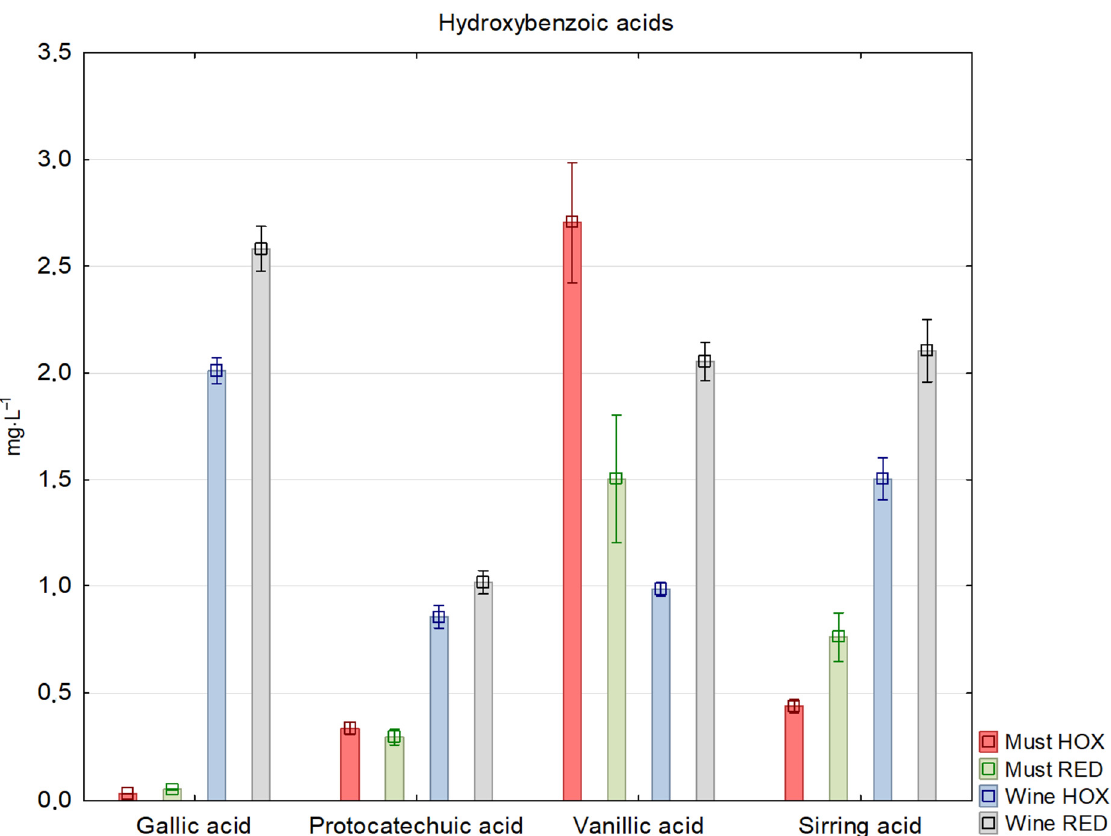
Figure 2. Concentration of selected hydroxybenzoic acids and esters in reductive (RED) and hyperoxidized (HOX) musts and wines.